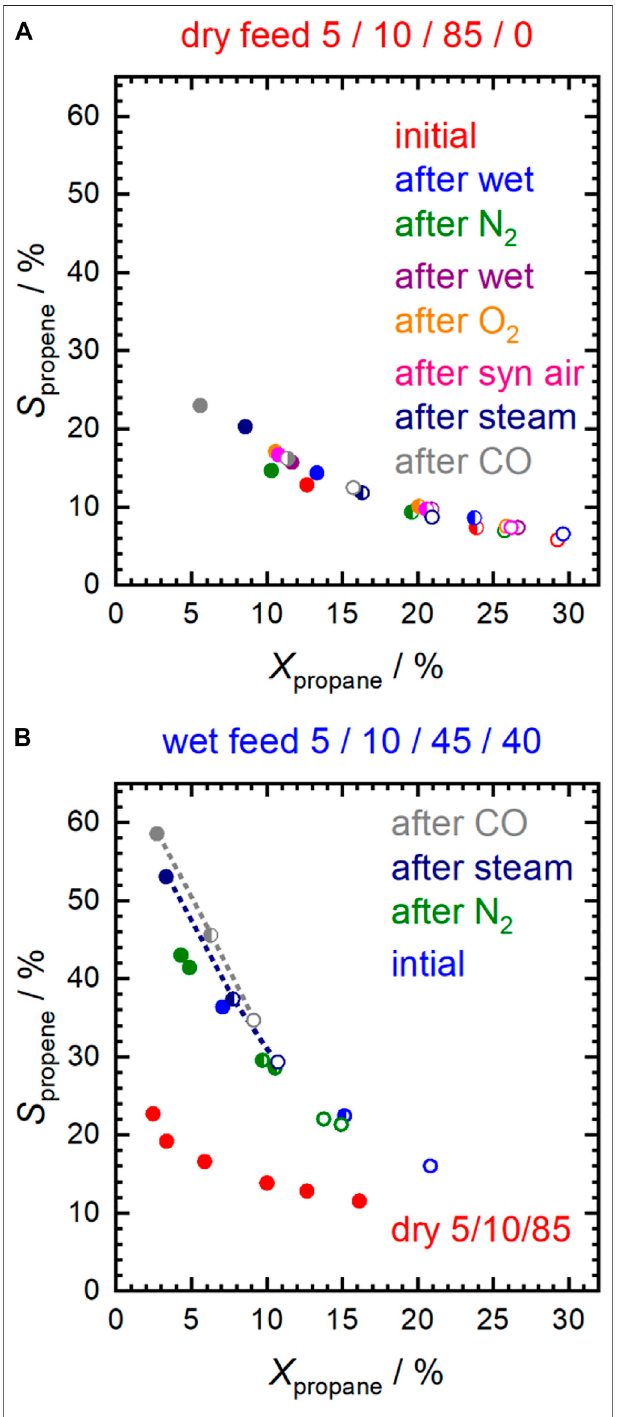
FIGURE 1 | Selectivity to propene in (A) dry feed (C 3 H 8 /O 2 /inert (cid:2) 5/10/ 85) and (B) in wet feed (C 3 H 8 /O 2 /inert/H 2 O (cid:2) 5/10/45/40) after speci fi c pretreatments at 450 ° C. Additionally, in (B) selectivity at different conversions in dry feed in the temperature range from 250 to 310 ° C is depicted for comparison (red data points). F/W (cid:2) 0.29 L · min − 1 · g − 1 (full symbols); F/W (cid:2) 0.16 L · min − 1 · g − 1 (half- fi lled symbols); F/W (cid:2) 0.11 L · min − 1 · g − 1 (empty